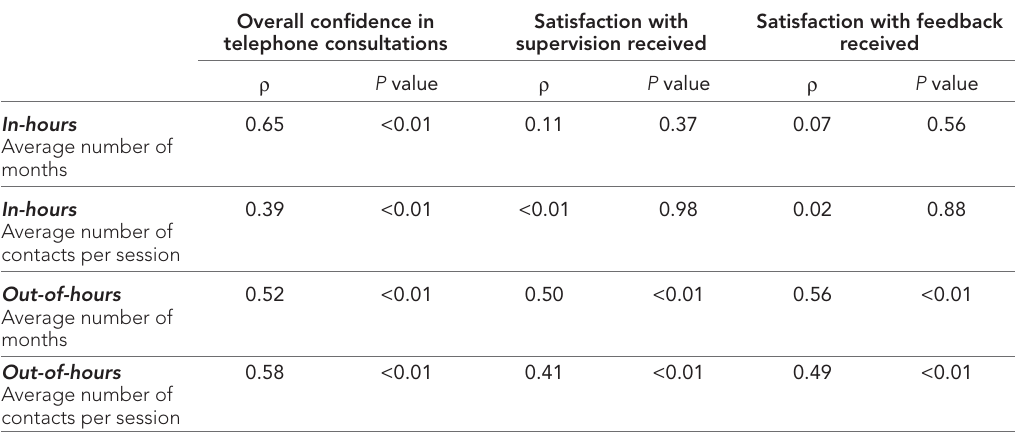
Table 2 Relationship between in- hours and out- of- hours experience, with overall confidence, and satisfaction with supervision and feedback Overall confidence in telephone